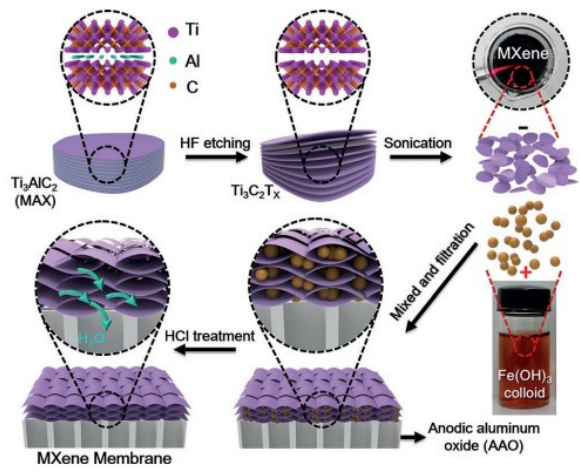
Figure 8. MXene membrane preparation, scheme taken from [95].